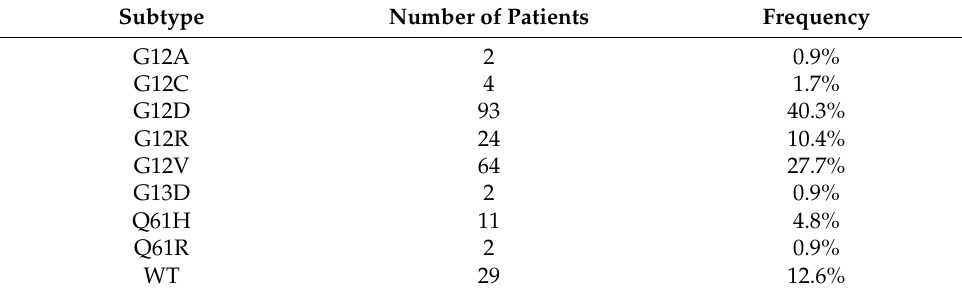
Table 2: KRAS mutation subtype frequency. WT,